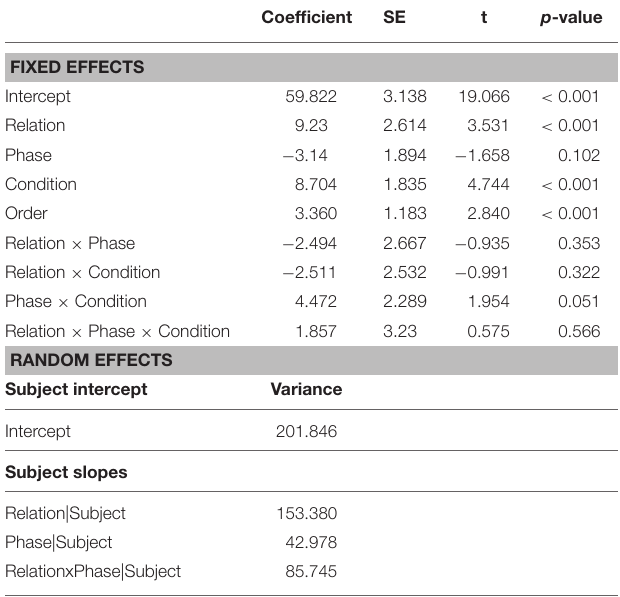
TABLE 2 | Results of the RT